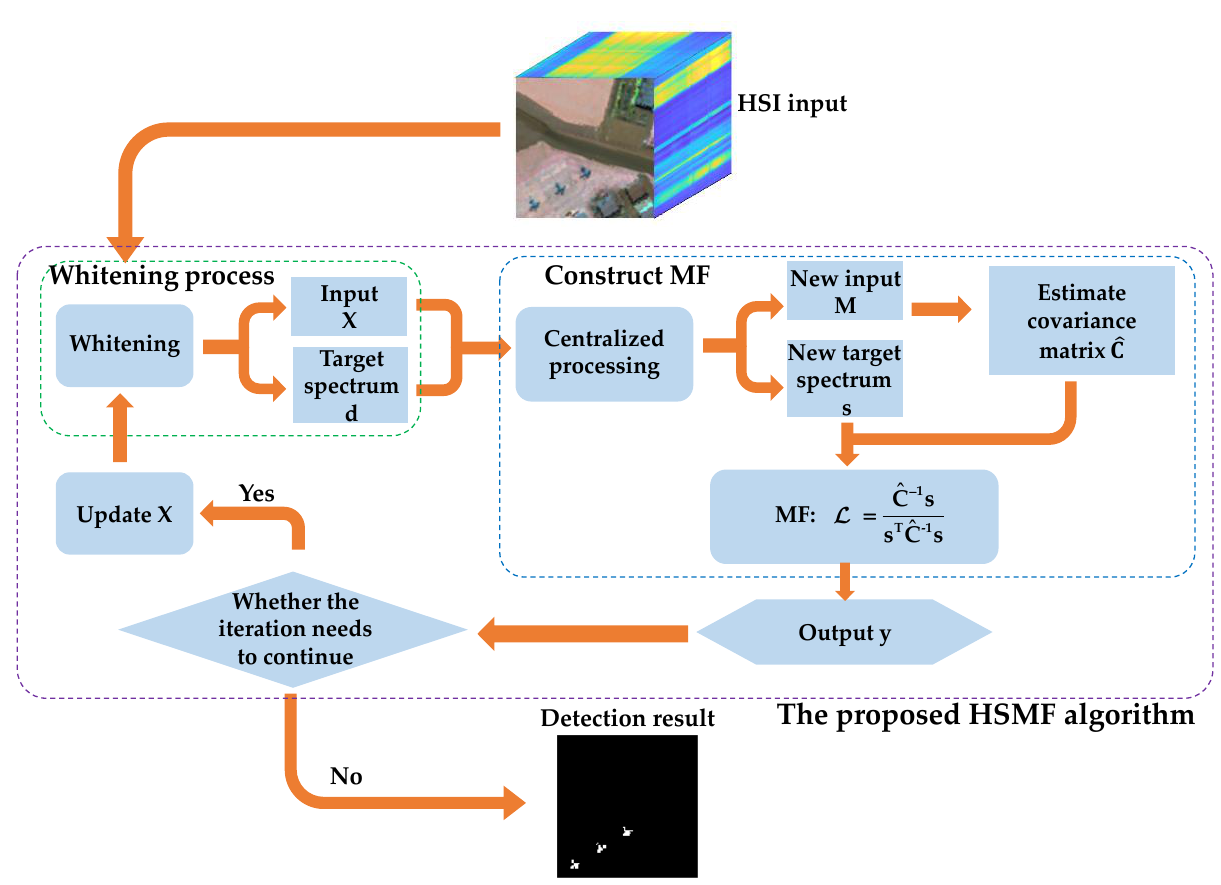
Figure 1. Flowchart of the proposed hierarchical background suppression on the matched filter detector (HSMF).